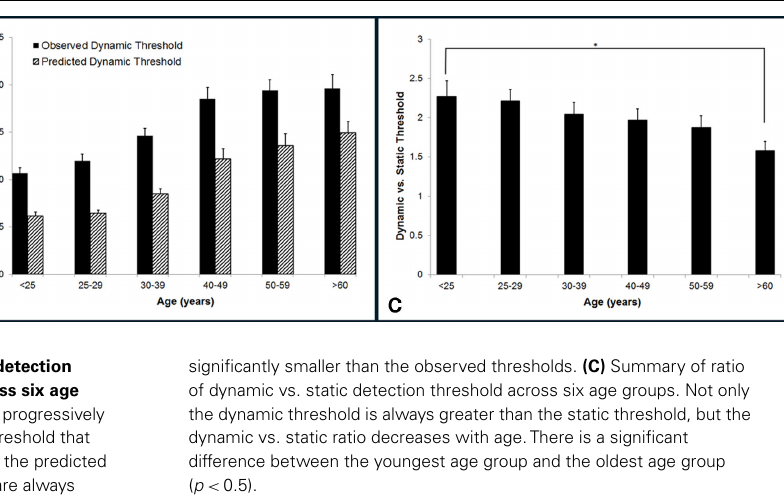
FIGURE 4 | Summary of group-averaged vibrotactile detection thresholds obtained with two different methods across six age groups. (A) Both static and dynamic detection threshold progressively rises with aging. All subjects demonstrated a dynamic threshold that was higher than their static threshold. (B) Comparison of the predicted and observed dynamic thresholds.The predicted values are always